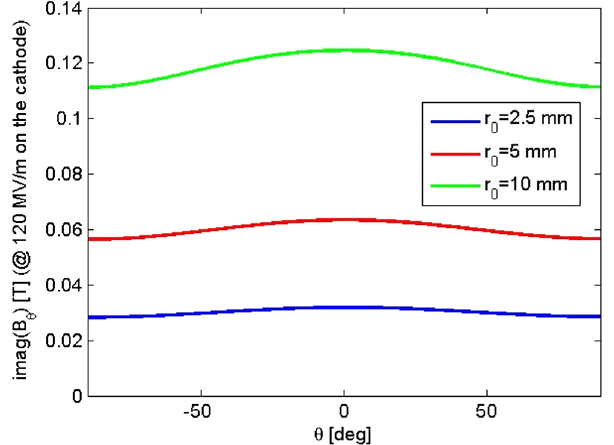
FIG. 35. Integrated quadrupole gradient in the gun as a function of the launching phase.FIG. 33. Phasor of the azimuthal magnetic field (that is purely